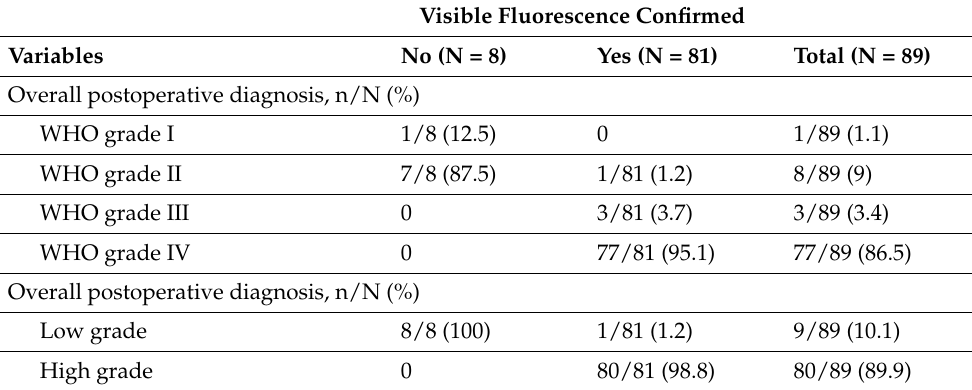
Table 3. Diagnosis (WHO 2021) of patients by fluorescence status for patients with available